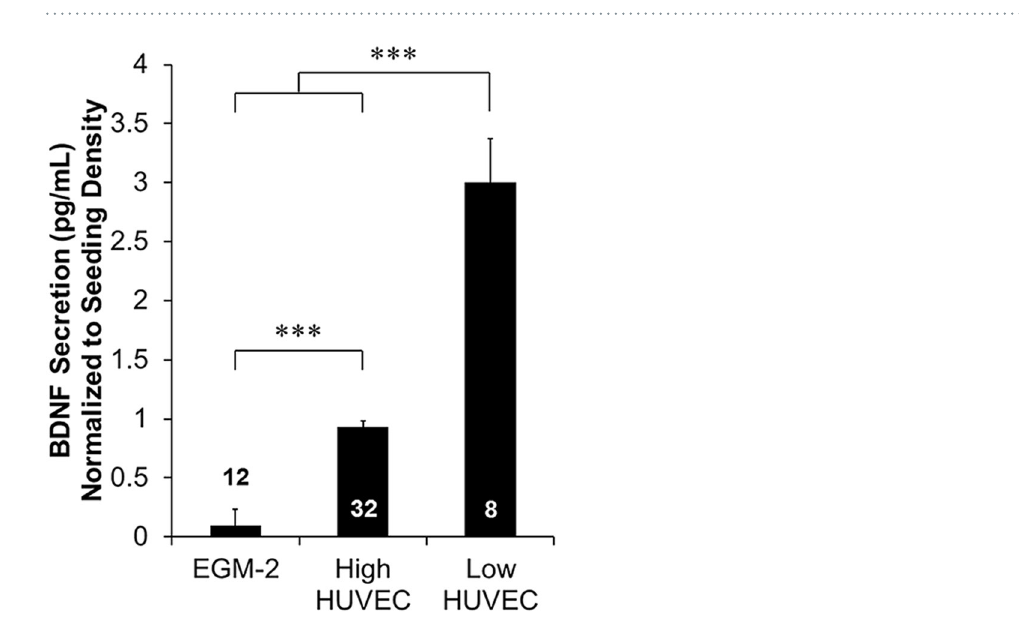
Figure 3. Neurotrophic factors secreted by HUVECs enhance axonal growth from DRG explants. Seven factors that were secreted by HUVECs and underexpressed in HUVEC-DRG co-cultures were selected from the results of the cytokine array. DRGs were cultured on PDL coated wells in either EGM-2 or DMEM medium supplemented with 0, 5, 50, or 100 µ g/mL of BDNF, GDNF, VEGF, IL7, OPN, PDGF- ββ , FGF4, or MIF for 4 days. All concentrations of BDNF and GDNF significantly enhanced axonal outgrowth. Axonal outgrowth was not affected by the concentration of the remaining growth factors, although there were some treatment groups, such as IL7, that displayed significantly higher axonal outgrowth when cultured in EGM-2 rather than DMEM. Data are presented as mean ± standard error. † (p < 0.05), †† (p < 0.01), ††† (p < 0.001) indicates significance from EGM-2 medium by two-tailed Student’s t-test; * (p < 0.05), ** (p < 0.01), *** (p < 0.001) and brackets indicate significance from indicated treatments as determined by one-way ANOVA with Holm-Sidak post hoc analysis (DRG sample size for each group shown in bars from 2 independent replicates). Comparisons of all other growth factors to controls were not significant (ANOVA).